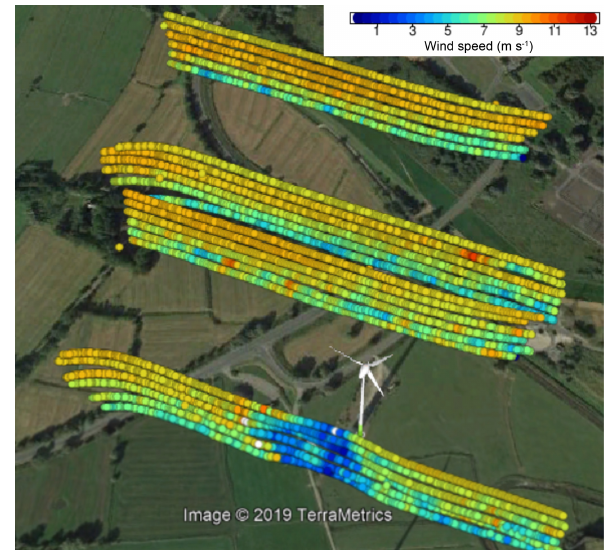
Figure 4. Isosurfaces of detached blade-tip and root vortices fol- lowing the λ 2 criterion for vortex identification. Here, the x axis follows the main wind direction. Numerical simulation of a generic model of an E-112 4.5MW converter.